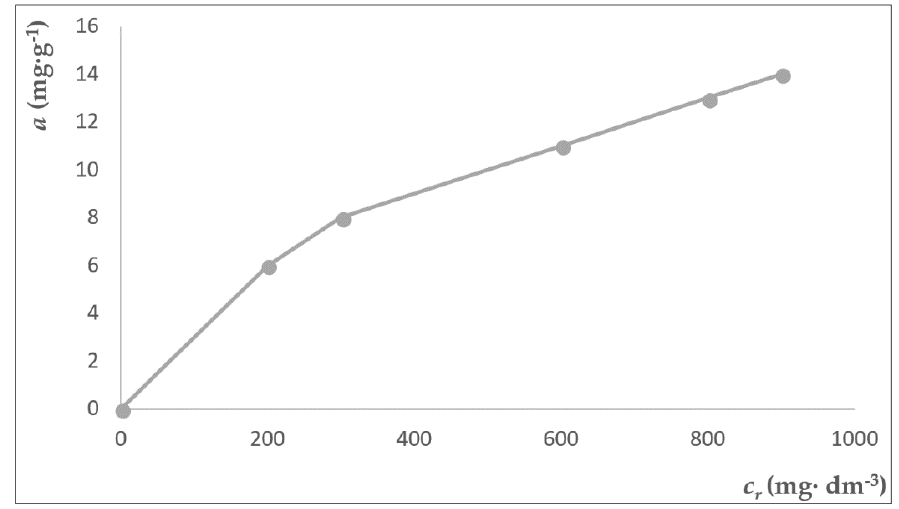
Figure 3. Sorption isotherm for sorption of cupric cations from solutions to clinoptilolite.